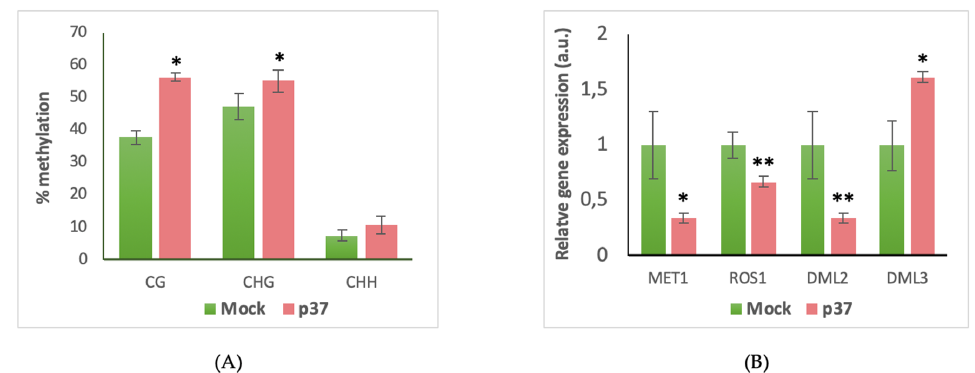
Figure 4. Analysis of the potential implication of the VSR p37 in rDNA promoter hypomethylation in N. benthamiana plants. (A) Differential DNA methylation levels between mock (green) and p37 (red) agroinfiltrated plants in the CG, CHG, and CHH sequence contexts. Error bars depict the